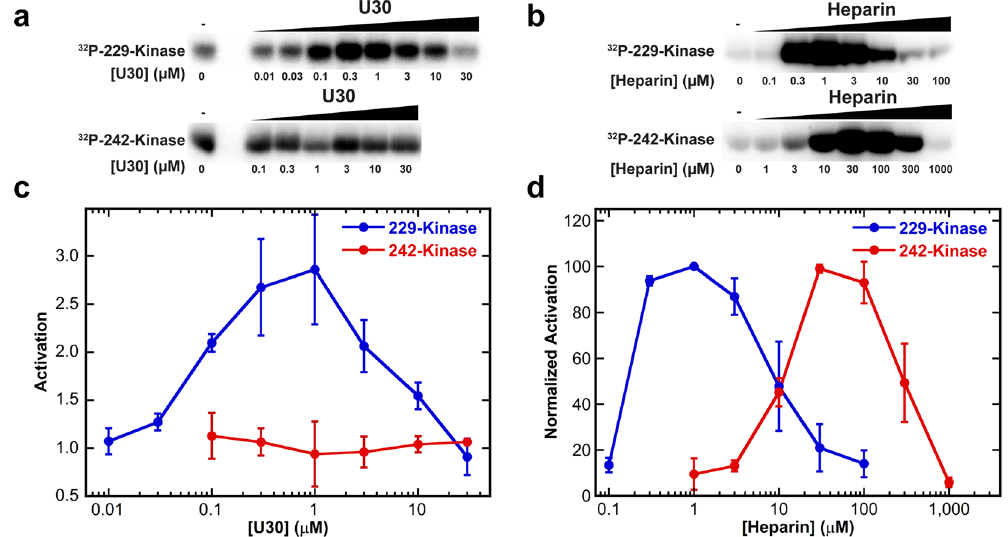
Figure 4. Activation of PKR kinase domain by ssRNA. Autophosphorylation reactions were carried out with a fixed concentration of protein and titrated with either U30 ( a , c ) or heparin ( b , d ). The basal (RNA- independent) activities of 229- and 242-kinase are much lower than the full length enzyme and are different from each other (Fig. S4). Thus, the protein concentrations were adjusted to give approximately equal extents of autophosphorylation in the absence of RNA: 1.5 µ M 229-kinase and 5 µ M 242-kinase. Phosphorimager scans of SDS-PAGE gels are shown in ( a ) and ( b ). The gels images are cropped to display the 32 P kinase domain bands and the contrast settings within each gel are independently adjusted using using ImageQuant TL software to clearly show the intensity trends. The quantitation of 32 P-incorporation is shown in ( c ) and ( d ). The error bars correspond to the standard deviation from three replicates. In ( c ), the activation by U30 is plotted relative to samples containing no activator. In ( d ), activation by heparin is normalized to the maximum signal because heparin is a potent activator and quantitation relative to the low signal in the absence of activator is not accurate. The ~100-fold increase in the heparin concentration required for maximal activation of the 242-kinase persists when the protein concentration is reduced to the same concentration used for 229-kinase (1.5 µ M). Note that the maximum concentration of U30 assayed was 30 µ M which is the peak of the 242-kinase heparin activation curve.